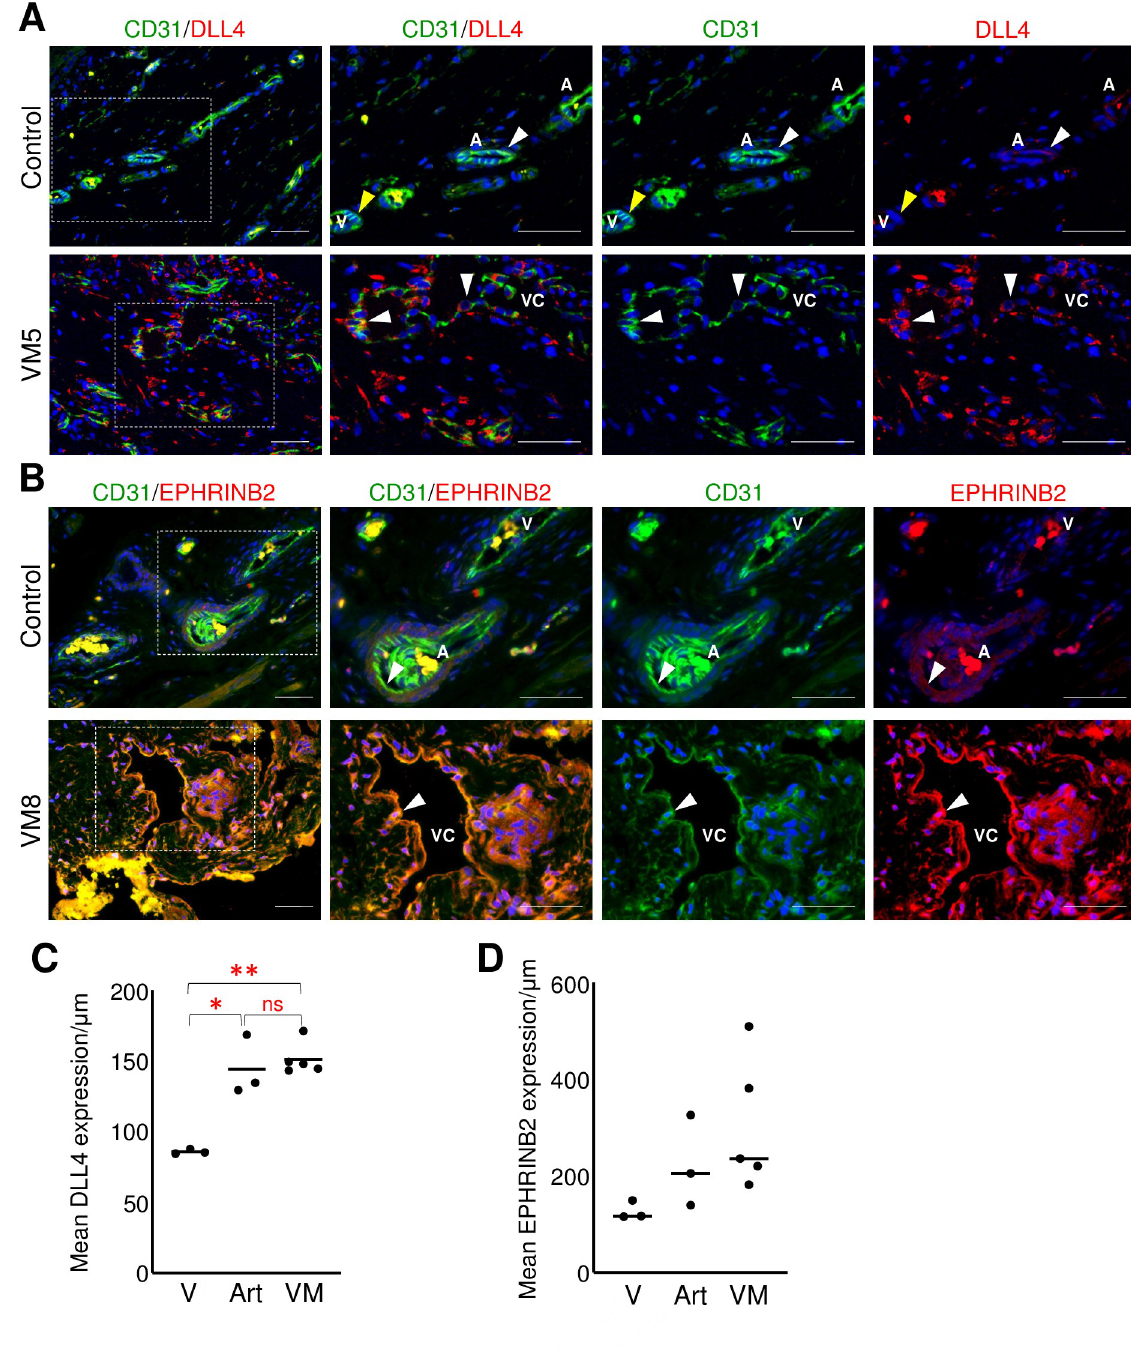
Fig 3. VM endothelium misexpressed arterial EC proteins. (A) Representative images of VM and control neonatal dermis co-stained for CD31 and DLL4. White arrowheads mark CD31+/DLL4+ ECs. Yellow arrowheads mark CD31+/DLL4- ECs. (B) Representative images of VM and control neonatal dermis co-stained for CD31 and EPHRINB2. White arrowheads mark CD31+/EPHRINB2+ cells. (A, B) Boxed areas are enlarged to the right. A-artery, V-vein, VC-VM channel. Scale bars– 50 μ m. (C). Mean DLL4 expression normalized by vessel length in VMs (n = 5) and controls (n = 3). Bar represents median value; ANOVA, p < 0.0005; T-Test � p < 0.01, �� p < 0.0001, ns, non-significant. (D) Mean EPHRINB2 expression normalized by vessel length in VMs (n = 5) and controls (n = 3). Bar represents median value. V-vein, Art- artery, VM-venous